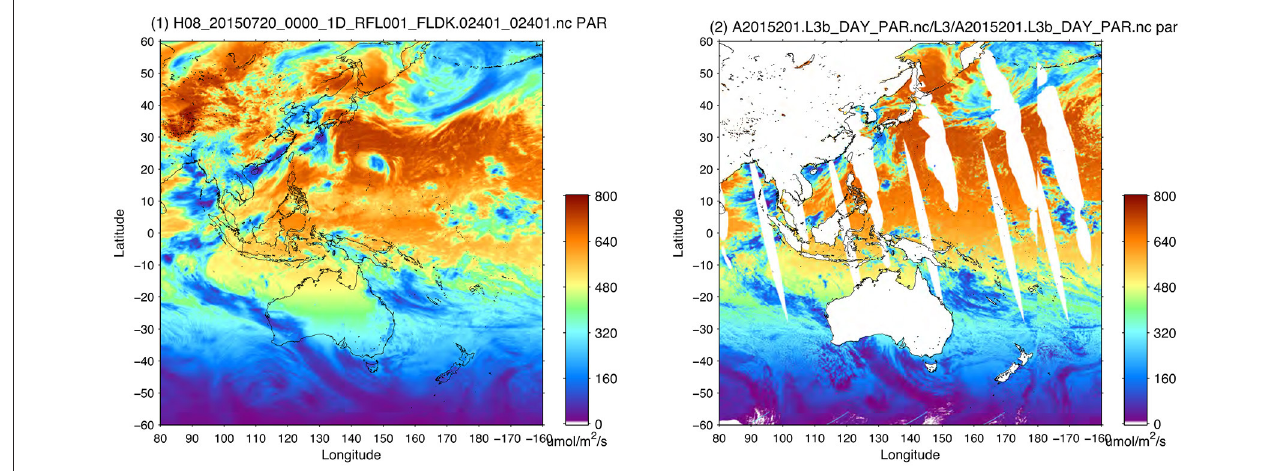
FIGURE 7 | Daily above-surface PAR for July 20, 2011 obtained from AHI (observations every 10min) and MODIS-A data at 9km resolution ( left and right , respectively). Patterns of spatial variability are similar for the two sensors, but the AHI PAR field is smoother, contains less extreme values, and does not exhibit spatial gaps (Courtesy of H. Murakami, Japanese Aerospace Exploration